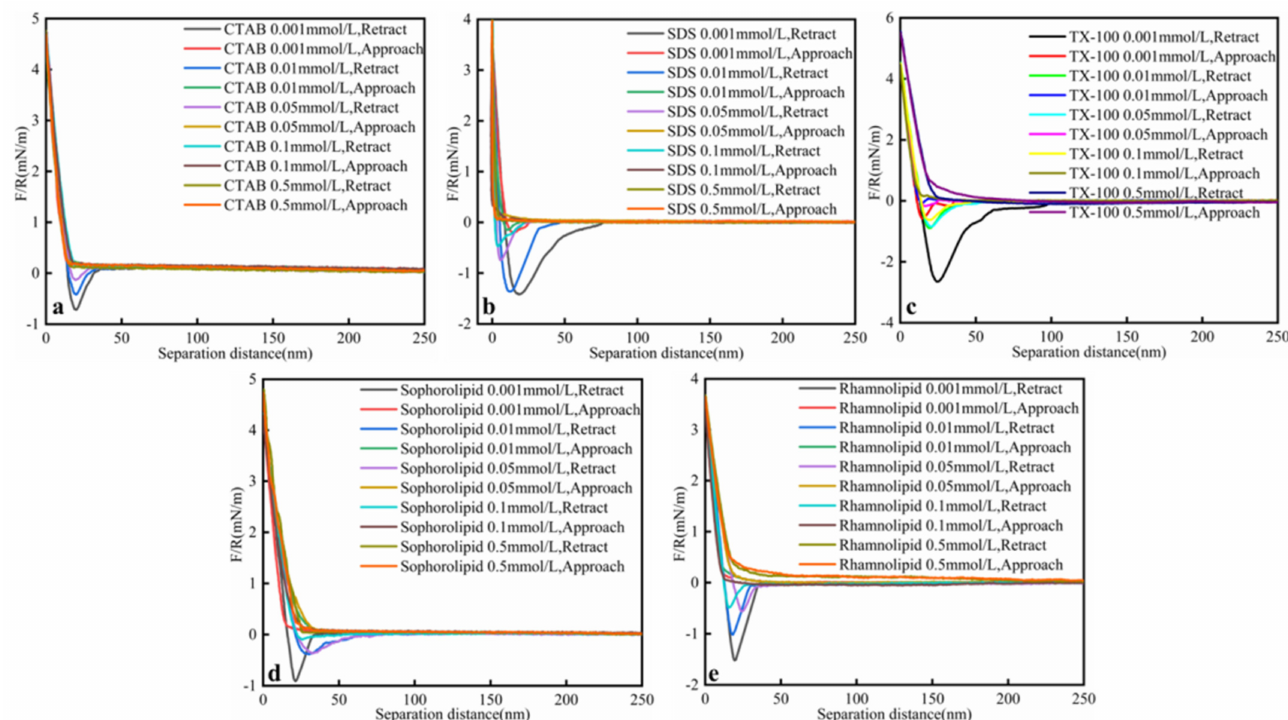
Figure 5. Interaction forces (F/R) between heavy oil and calcium carbonate in different surfactants concentrations ( a ) CTAB; ( b ) SDS; ( c ) TX-100; ( d ) Sophorolipid; ( e ) Rhamnolipid solutions as a function of the separation distance at ambient